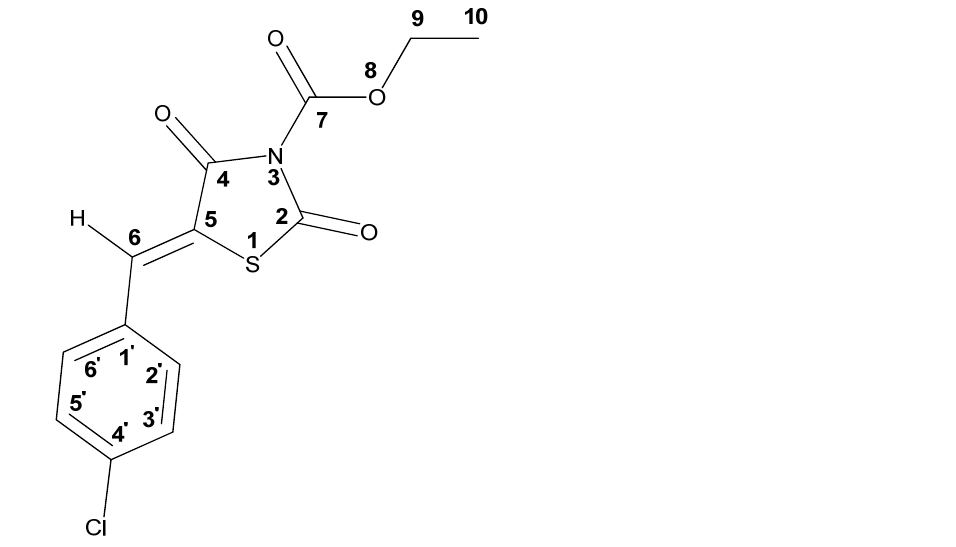
Figure 4. Chemical structure of ethyl (Z) -5-(4-chlorobenzylidene)-2,4-dioxothiazolidine-3-carboxylate ( 5a ). Table 1. 1 H Chemical shifts of 5a in DMSO ‐ d 6 and CDCl 3 at 400 MHz.